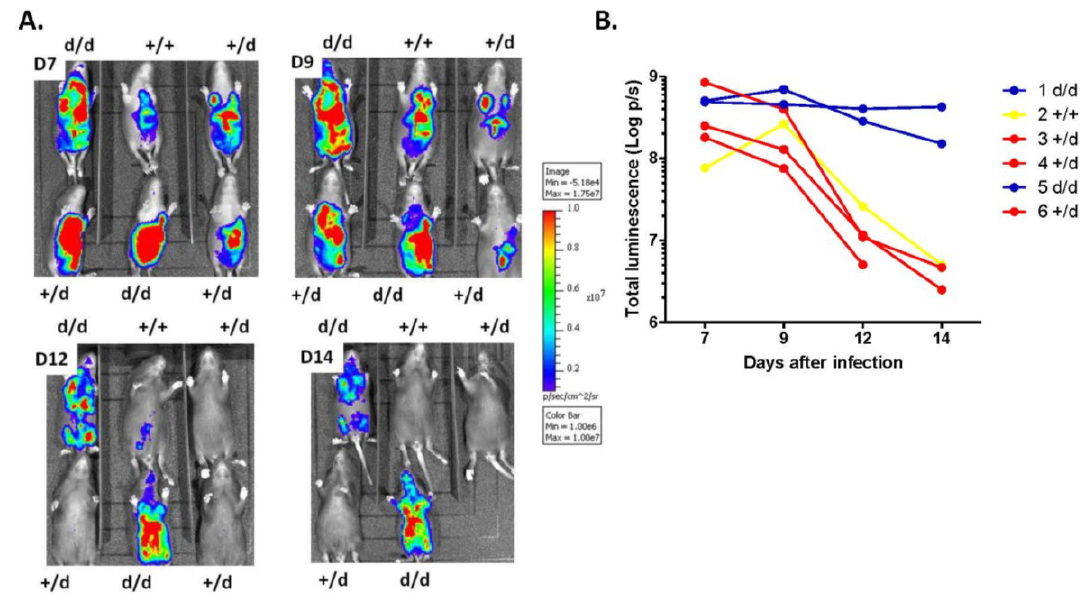
Figure 2. In vivo imaging reveals increased MCMV replication in infected Dicer-deficient neonates. ( A ). Snapshot images showing the luminescence emitted by MCMV-Luc-infected animals 7, 9, 12 and 14 days after infection. The genotype of the animals is indicated. ( B ). time-course analysis of luminescence (expressed in Log photons/sec or p/s) quantified for each animal presented in A. Wild-type control (Dicer +/+ , animal n° 2 in yellow), heterozygotes (Dicer +/d , animals 3, 4 and 6 in red) and mutants (Dicer d/d , animals 1 and 5 in